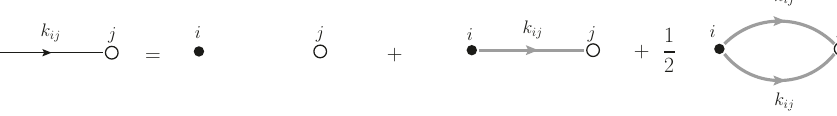
Figure 13 . Expansion of the exponential factor corresponding to a black line in the (cid:18) -graph. In the right hand side, each grey line corresponds to a (cid:18) i k (cid:22) (cid:18) j term.